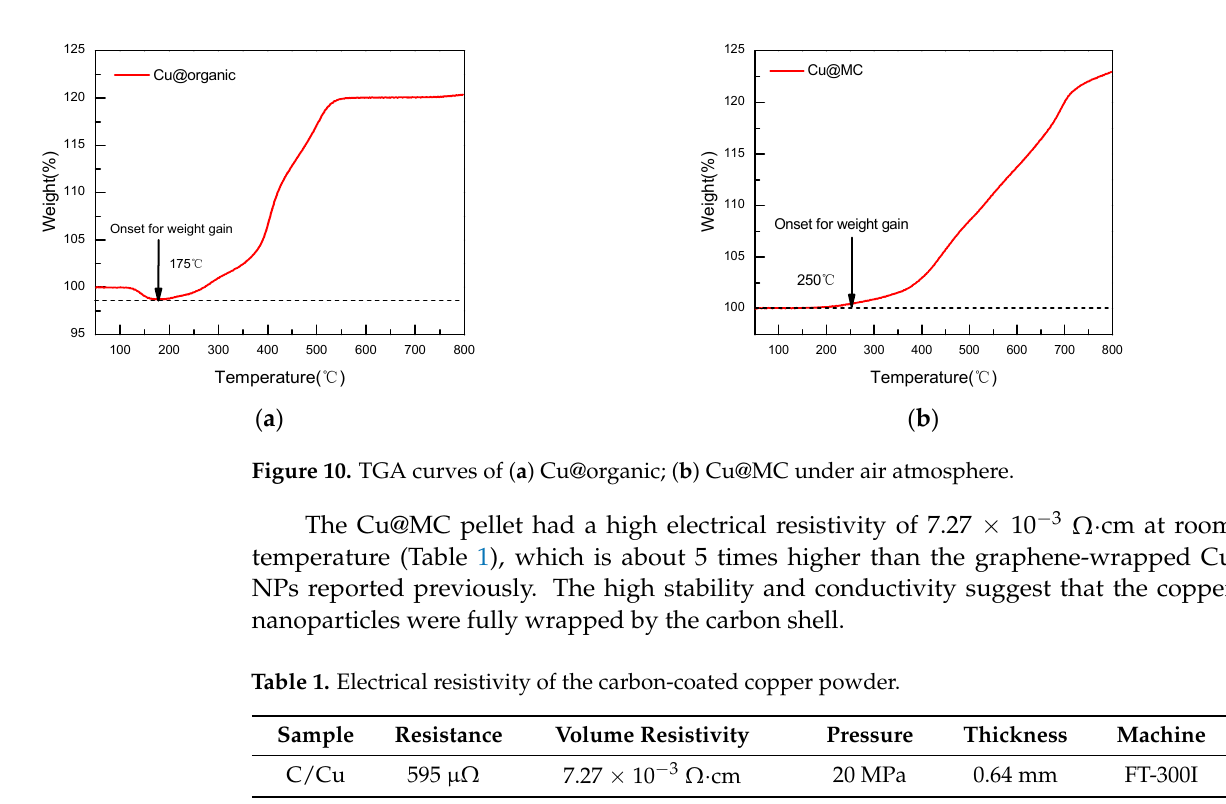
( b ) Figure 9. ( a ) TGA curves of Na-PNFS and PVP under nitrogen atmosphere; ( b ) Raman spectra of Na-PNFS and PVP residue after annealing at 900 °C for 2 h in nitrogen atmosphere. The oxidation of copper nanoparticles can be observed through the weight gain of